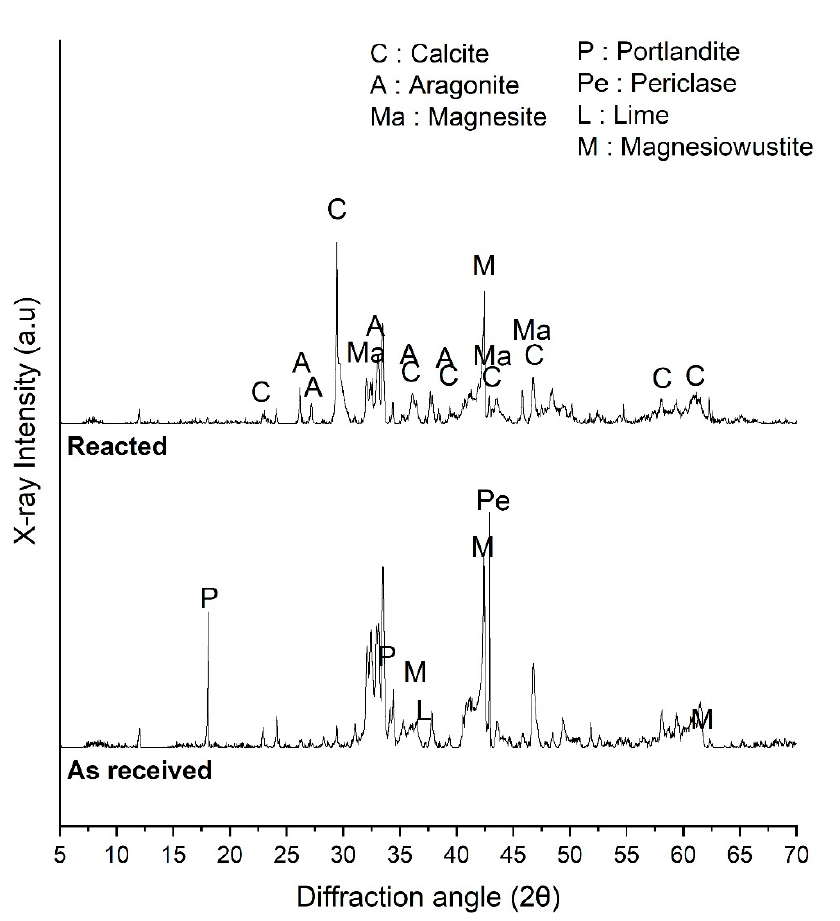
Figure 3. XRD pattern of converter slag reacted with supercritical carbon dioxide.